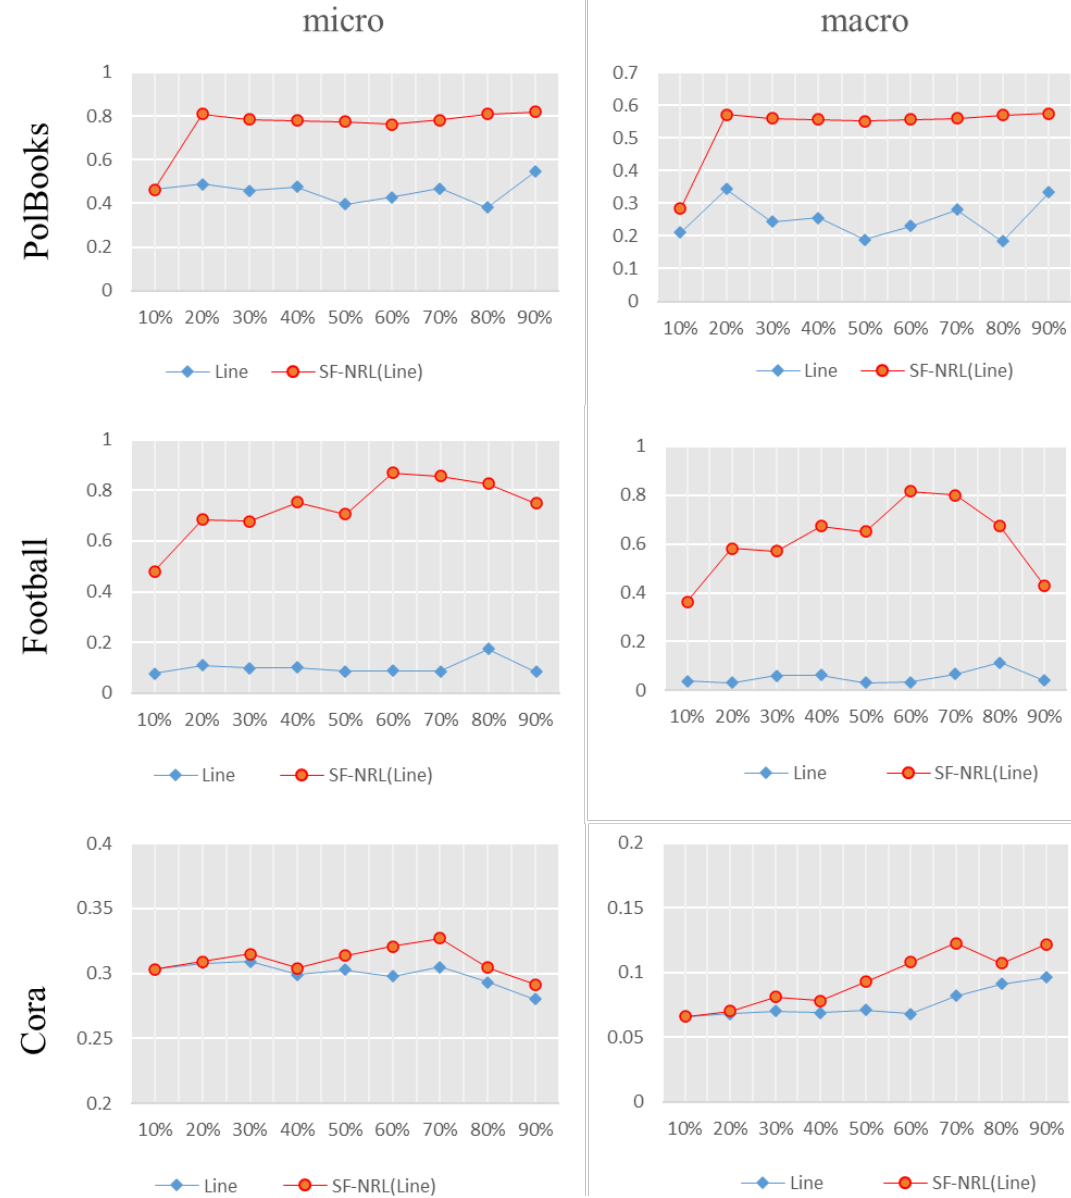
Figure 8. Comparison of F 1 value of the multi-label classification experiment results. The red polyline is the F 1 value of SF-NRL(LINE) and the blue one is that of LINE.